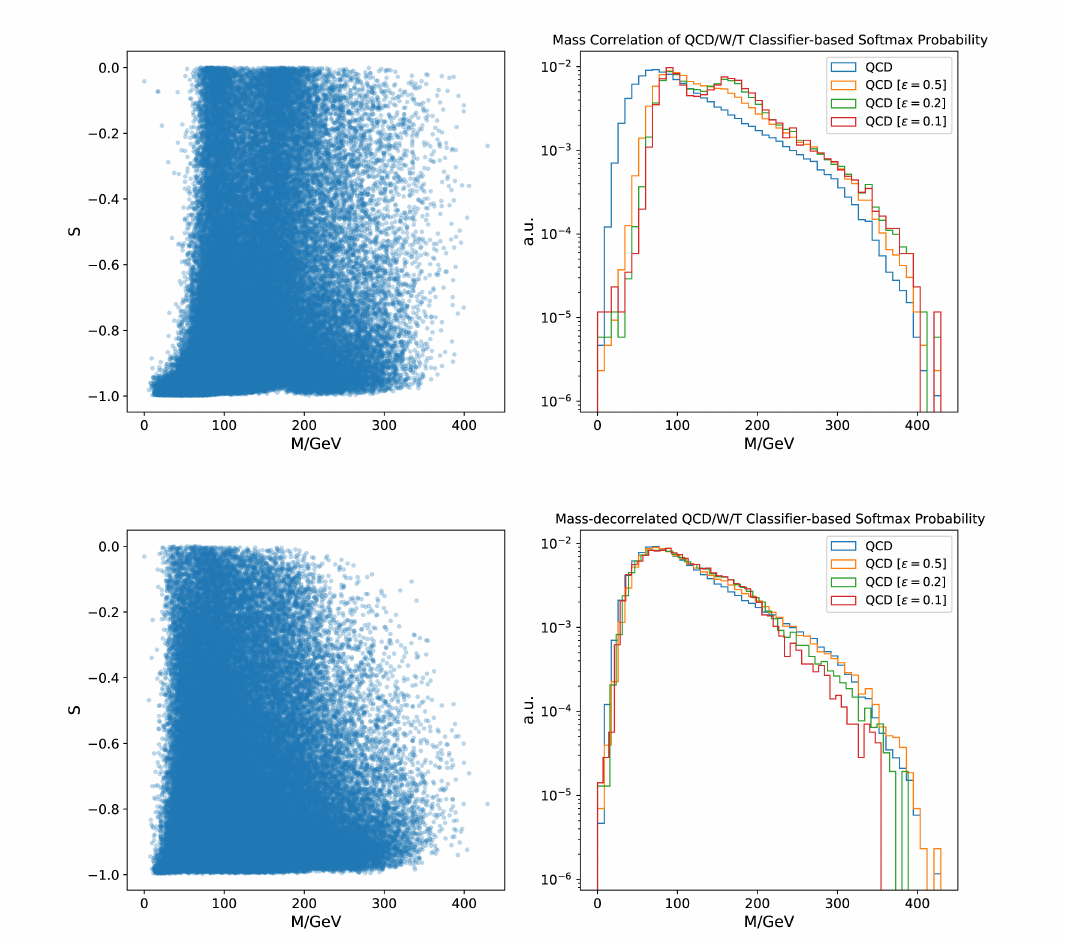
Figure 9 . Ensemble Model. Top : The un-decorrelated model with p QCD as the anomaly score. Bottom : The mass-decorrelated model with p QCD as the anomaly score. Left : The correlation between jet mass M and the anomaly score. Right : Mass distributions for different background acceptance rates ( (cid:15)